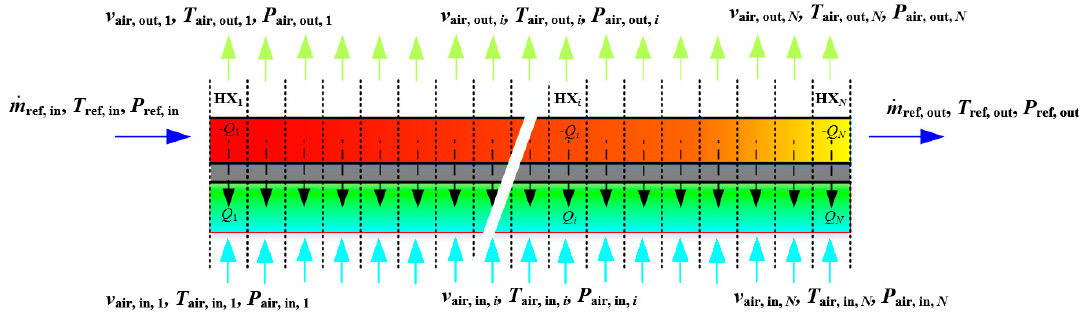
Figure 2. Segment by segment design for single tube with cross